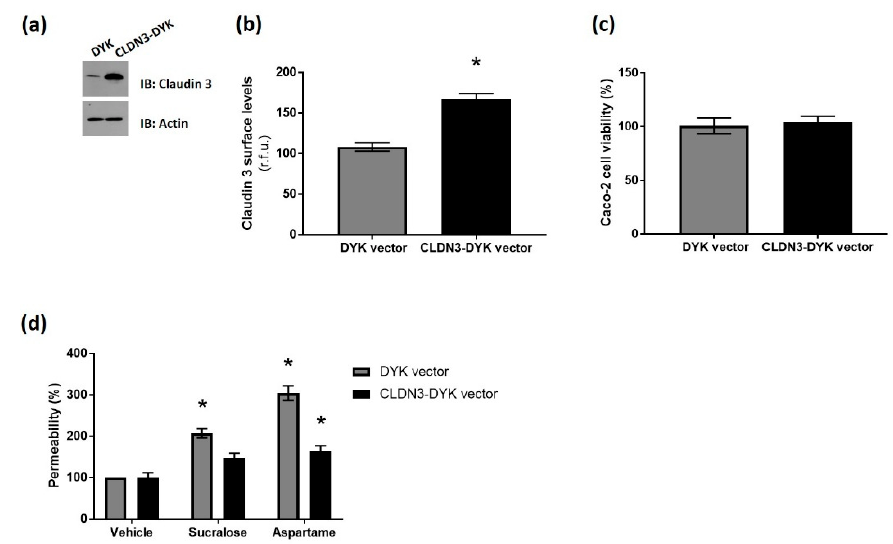
Figure 5. Overexpression of claudin 3 rescues sweetener-induced barrier leakage across the intestinal epithelium. Caco-2 cells were transiently transfected with cDNA encoding wild-type claudin 3 (CLDN3-DYK) or the vector control (DYK), or untransfected (UT) for 48 h. ( a ) The total protein levels of claudin 3 in cells were measured by the Western blot analysis of cell lysates using 50 µ g protein. ( b ) The cell surface expression of claudin 3 was determined by whole-cell indirect ELISA using chemiluminescence in transfected Caco-2 cells. ( c ) The viability of transfected Caco-2 cells was assessed by a CCK8 assay. Absorbance values were normalized to untransfected control and expressed as percentage viability. ( d ) The permeability of the transfected Caco-2 cell monolayer was measured by an FITC-dextran assay following exposure to sucralose and aspartame (0.1 mM) for 24 h. % permeability was calculated normalized to vehicle treatment. n = 6. Data are expressed as mean ± S.E.M. * p < 0.05 versus untransfected cells or vehicle (0 µM).